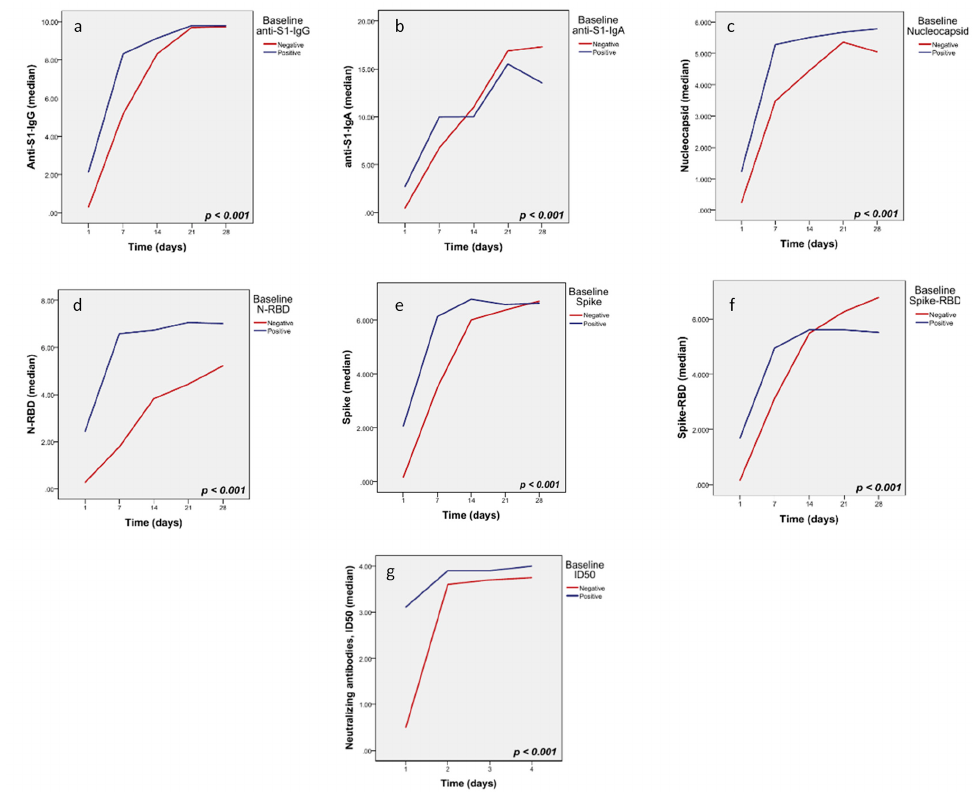
Figure 3. Trend of antibodies by baseline antibody level: ( a ) anti-S1 IgG, ( b ) anti-S1-IgA, ( c ) Nucleocapsid, ( d ) N_RBD, ( e ) Spike, ( f ) Spike_RBD, ( g ) neutralizing antibodies (ID 50 ).